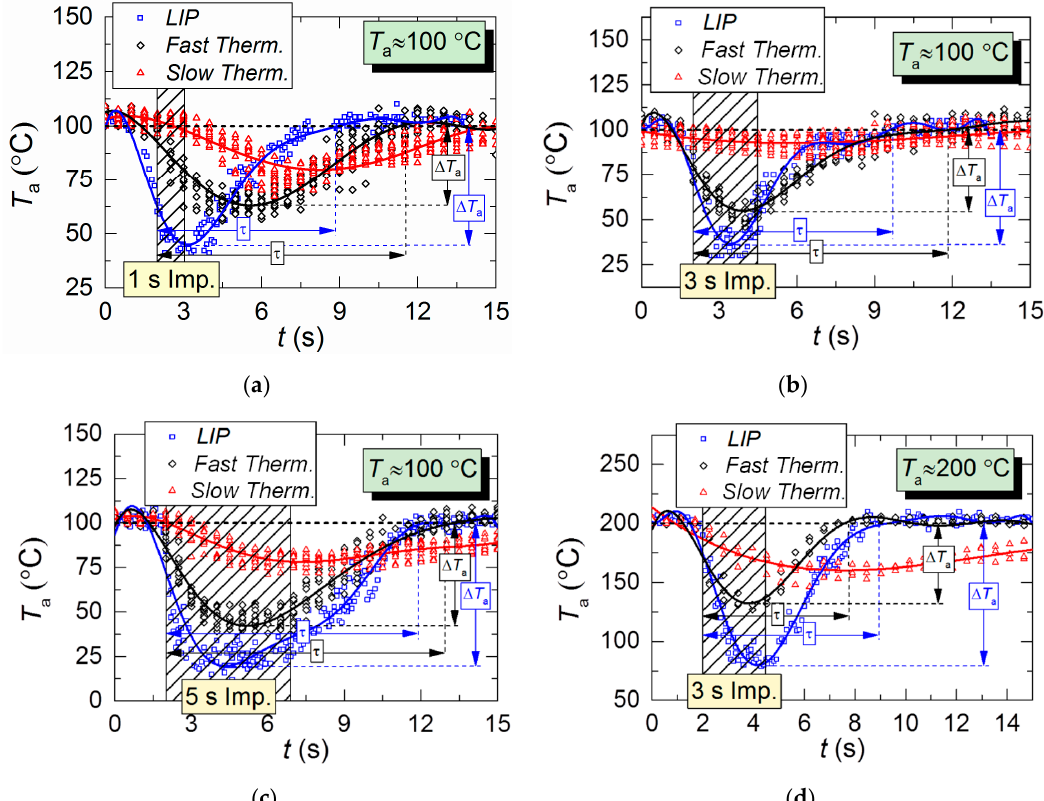
Figure 8. Temperature variations of kerosene combustion products with time in the trace of droplet flow for a single 1s injection of droplets; initial air temperature: ( a – c ) T a ≈ 100 °C; ( d ) T a ≈ 200 °C.